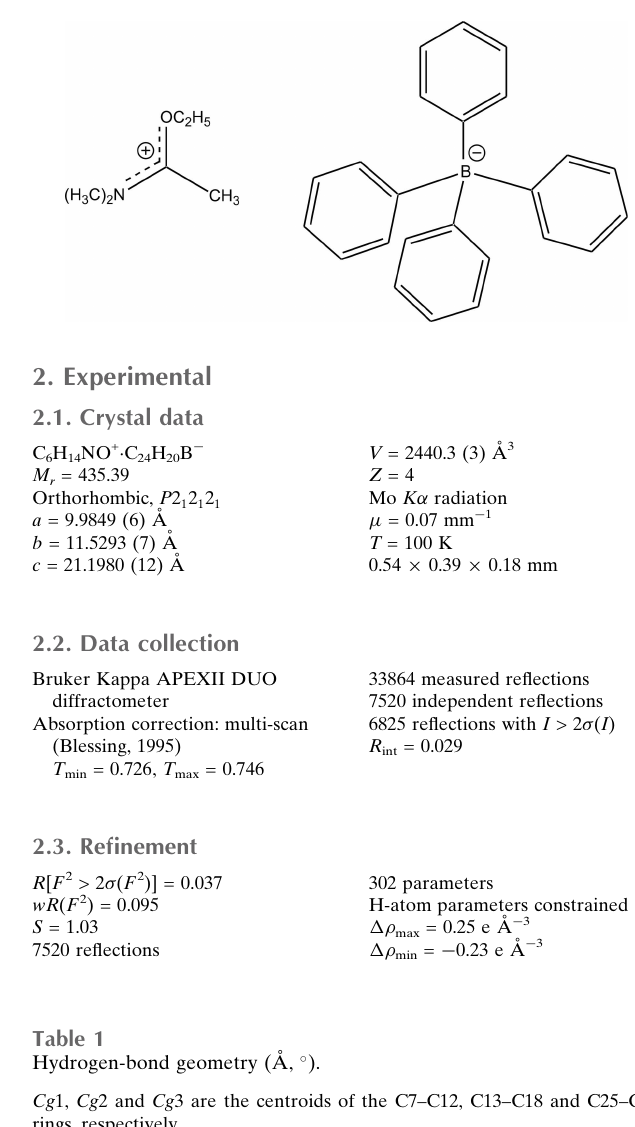
Hydrogen-bond geometry (A˚ , (cid:5)